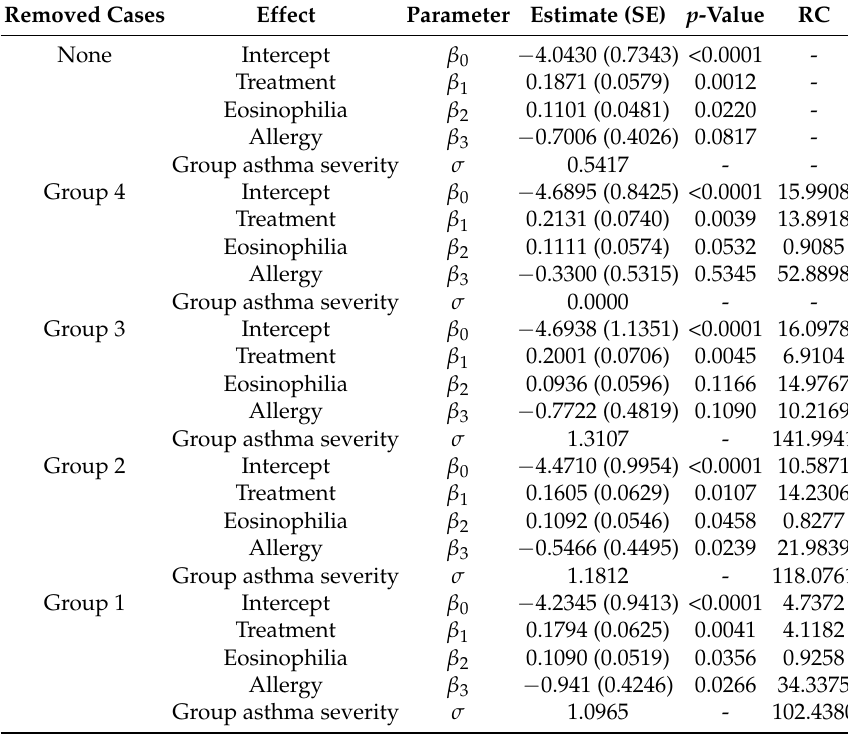
Table 6. Estimates (SE), p -values and RC under local influence diagnostics for the asthma data.